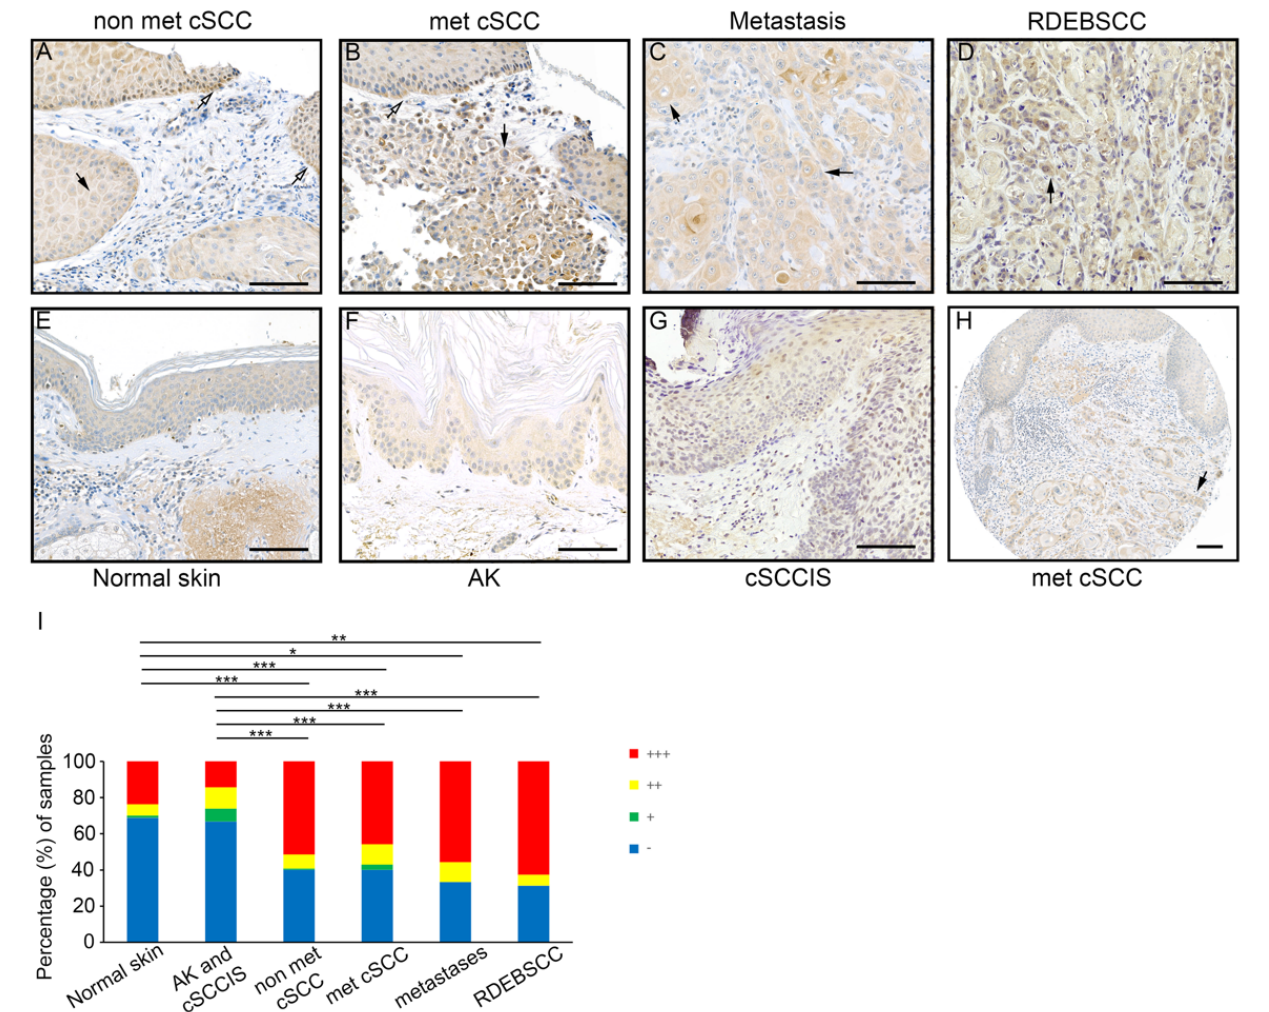
Figure 2. Expression of FD in cSCC tumor cells in vivo. ( A )–( G ): TMA sections of primary non- metastatic cSCC ( n = 140), metastatic cSCC ( n = 70), cSCC metastases ( n = 9), RDEBSCC ( n = 16), normal skin ( n = 80), AK ( n = 65) and cSCCIS ( n = 61) were stained by immunohistochemistry with anti-FD antibody. Specific strong (+++) staining for FD was detected in tumor cells in the invasive edges (white arrows) and/or large more differentiated single cells (black arrows) of non-metastatic cSCC ( A ), metastatic cSCC ( B ), cSCC metastases ( C ) and in RDEBSCC ( D ). In normal skin ( E ), AK ( F ) and cSCCIS ( G ), the FD staining was weaker and showed a homogenous diffuse distribution through the whole epidermis. ( H ) Cytoplasmic FD staining was scored strong in metastatic cSCC cells of the tumor islands in dermal layer, whereas the adjacent epidermis showed weaker staining.